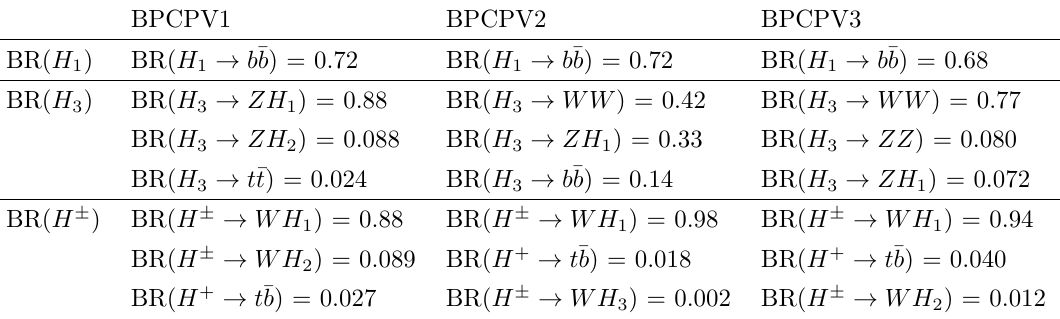
Table 9 . The dominant branching ratios of the BPCPV1-3 Higgs